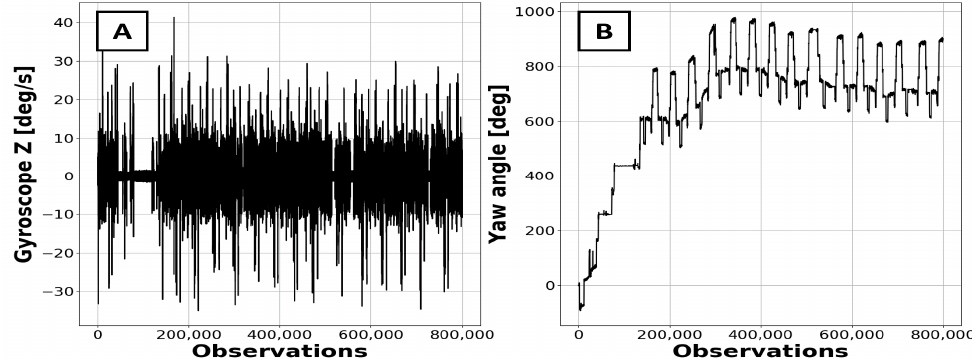
Figure 3. Input data: ( A ) Raw signal from the gyroscope Z -axis; ( B ) Yaw angle signal generated from the gyroscope. The increase at the beginning of the signal corresponds to the vehicle leaving the heavy machinery chamber, which subsequently took turns in the same direction. The regular part of the signal corresponds to the haulage cycles, where the haul truck was moving from the mining face to the dumping point, using the same path.